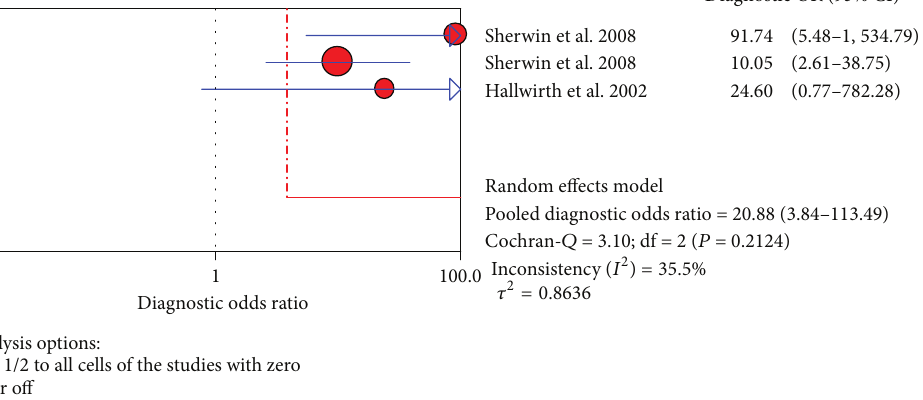
Figure 12: Forest plot for diagnostic OR of the TNF- 𝛼 test to diagnose neonatal sepsis at the LONS in the southern hemisphere.